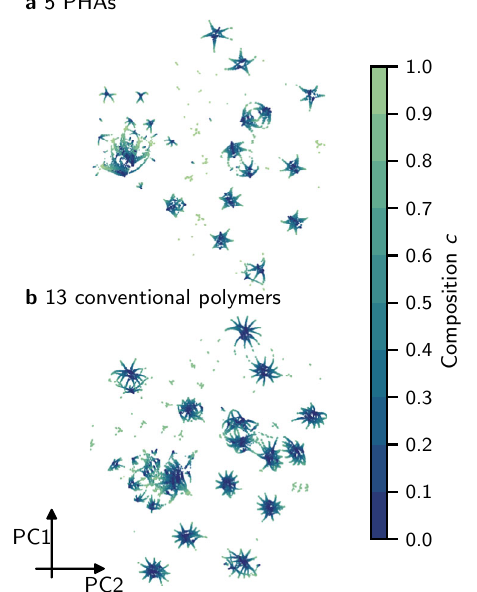
Fig. 2 Two-dimensional UMAP 41 plot of two fi ngerprint subspaces that contain only fi ngerprints of selected polymers. a Five PHAs. The dark green dots ( c = 1) show the fi ngerprints of the SMILES strings [*] OCCC( = O)[*] , [*]OC(O)CC( = O)[*] , [*]OC(C( = O)O)CC( = O) [*] , [*]OC(C( = O)OC)CC( = O)[*] , and [*]OC(N)CC( = O)[*] . b 13 conventional polymers. The dark green dots show the fi ngerprints of the 13 conventional polymers. The dark blue dots ( c = 0) in panels a and b indicate the fi ngerprints of the remaining 548 and 540 polymers in the bioplastic search space (a total of 553 polymers), respectively. The dots with intermediate colors (green to blue) indicate the fi ngerprints of connecting copolymers. PC1 and PC2 represent the fi rst and second principal components in the UMAP projection, respectively.